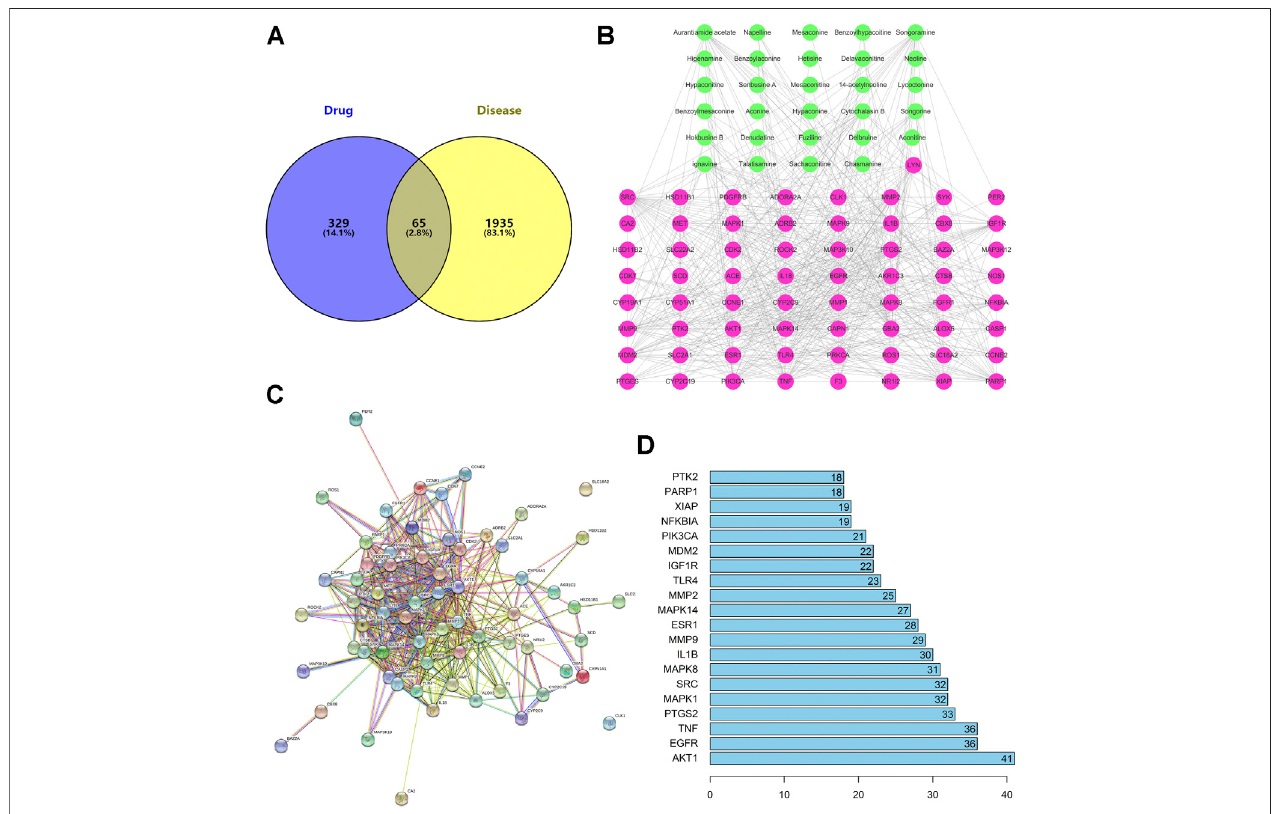
FIGURE 3 | (A) There are 65 overlapping targets between disease and drug. (B) C – T network. The 29 green nodes indicate the active ingredients of GA for drug treatment.The65pinknodesindicatecoincidenttargetsbetweendiseaseanddrug.Theedgesdenotethatnodescaninteractwitheachother. (C) PPInetwork. (D) Bar plot of the PPI network. The x-axis represents the number of neighboring proteins of the target protein. The y-axis represents the target